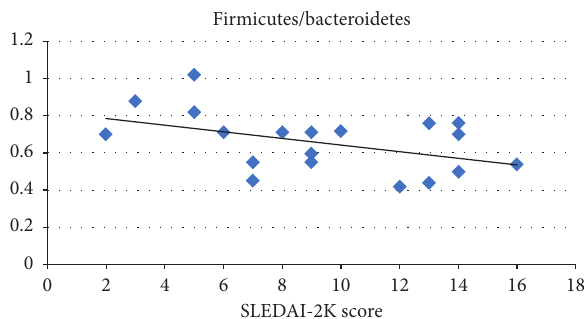
Figure 3: Negative correlation between SLE disease activity and F/ B ratio.